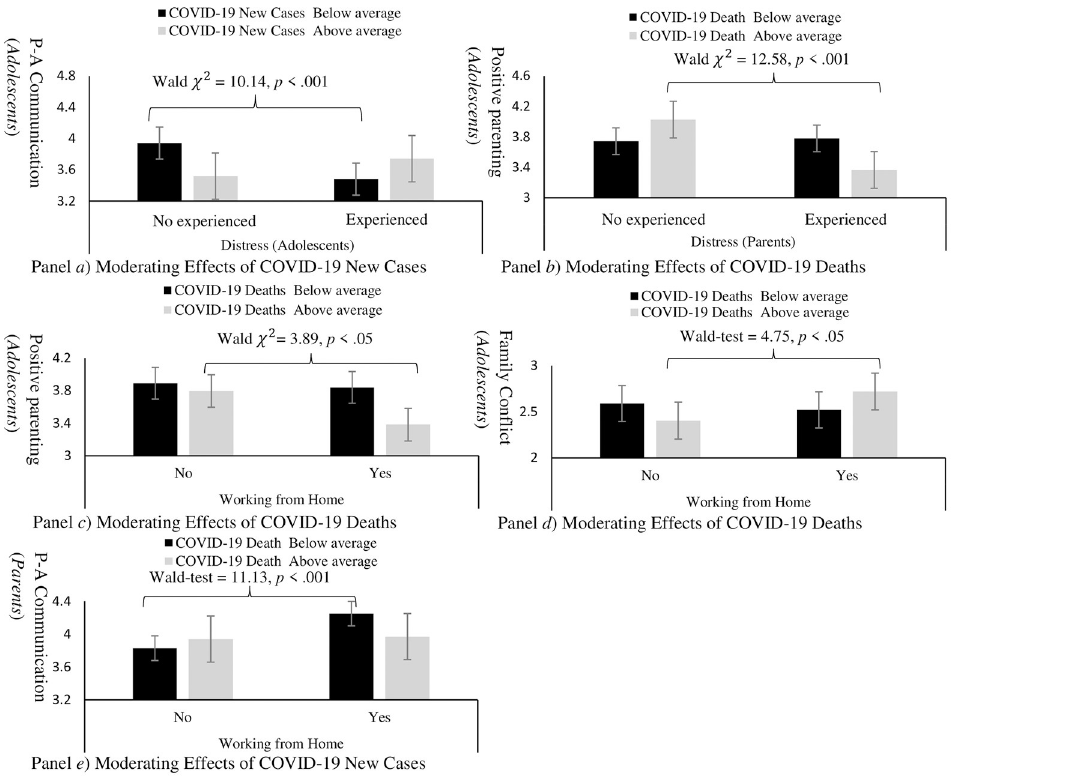
Fig 1. Moderating effects of COVID-19 daily